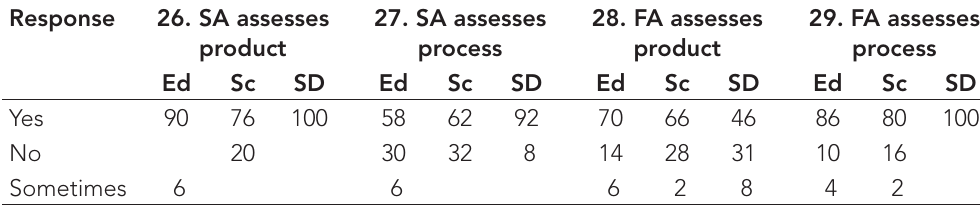
Table 11: Summative and formative assessment assess product and/or process